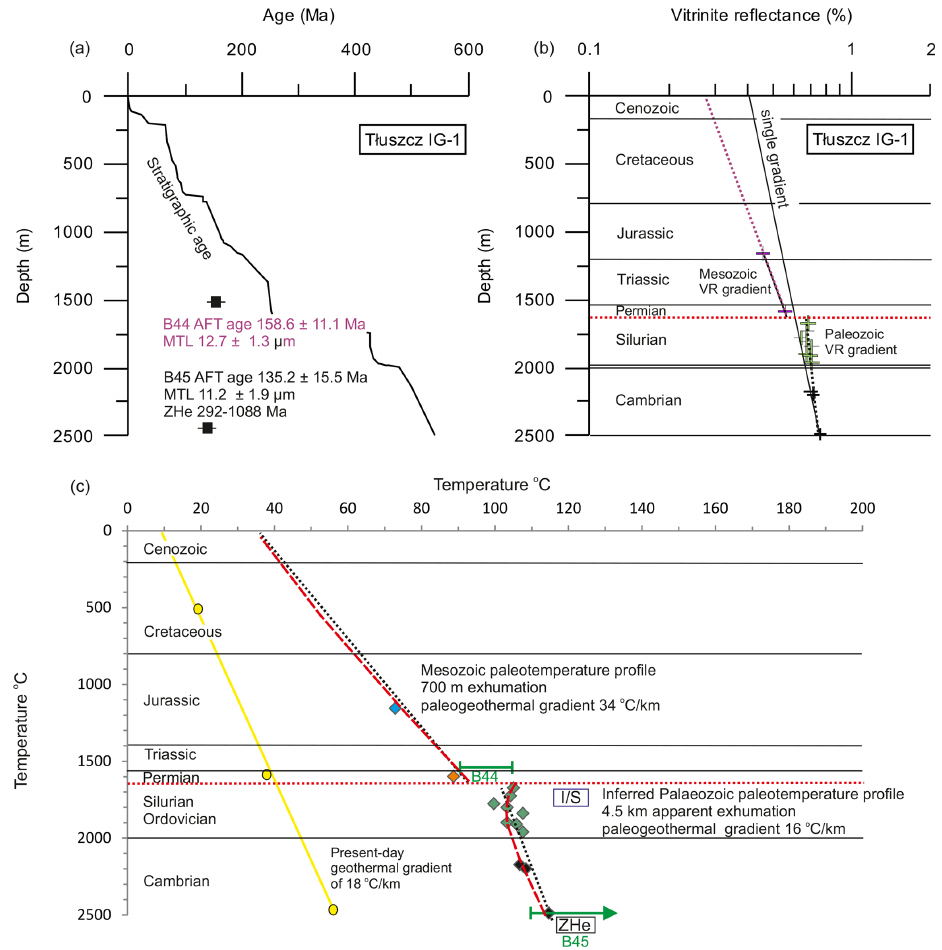
Figure 9. Tłuszcz IG-1 borehole data (Podlasie Basin). (a) Thermochronological data vs. stratigraphic age, (b) VR profile, (c) paleotempera- ture profile. Note a thermal maturity break at the unconformity between the Permian–Mesozoic and Silurian. The Mesozoic paleotemperature profile shows 700m of exhumation with a paleogeothermal gradient of 34 ◦ Ckm − 1 . The inferred Paleozoic paleotemperature profile shows 4.5km of apparent exhumation with a paleogeothermal gradient of 16 ◦ Ckm − 1 . A nonlinear VR profile suggests a fluid flow event. Other explanations are as in Figs. 6 and 7. Illite K-Ar ages from Silurian bentonites are 334–311Ma (mid-late Carboniferous) in the adjacent Go´zdzik OU-1 well (Kowalska et al.,